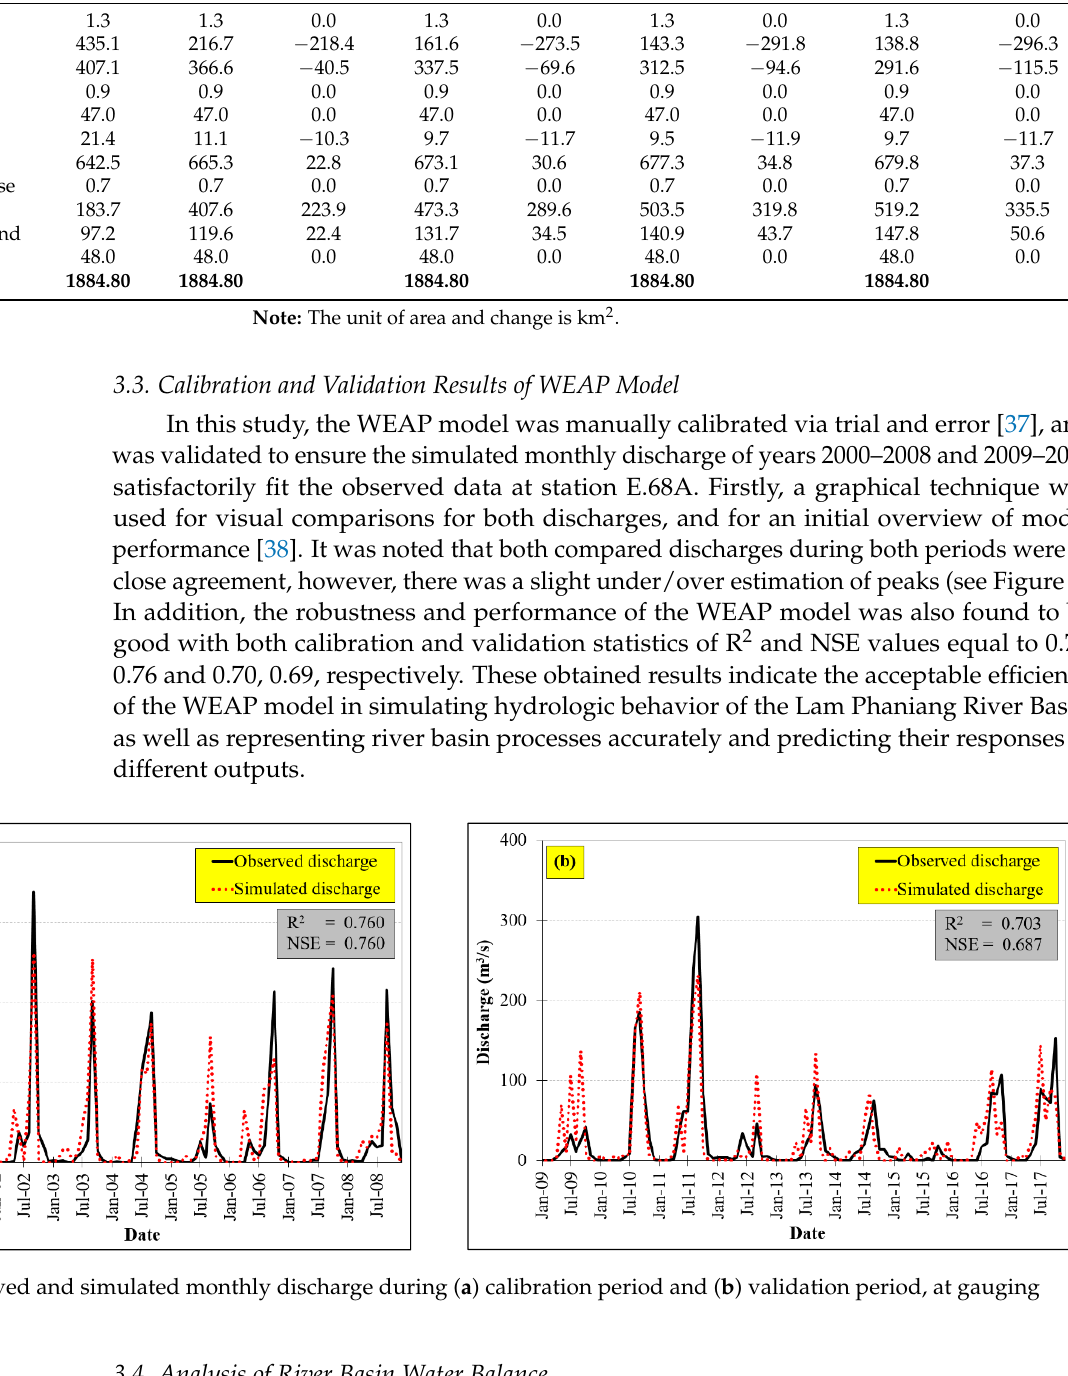
Table 3. Changes in future land use patterns compared to the year 2015.